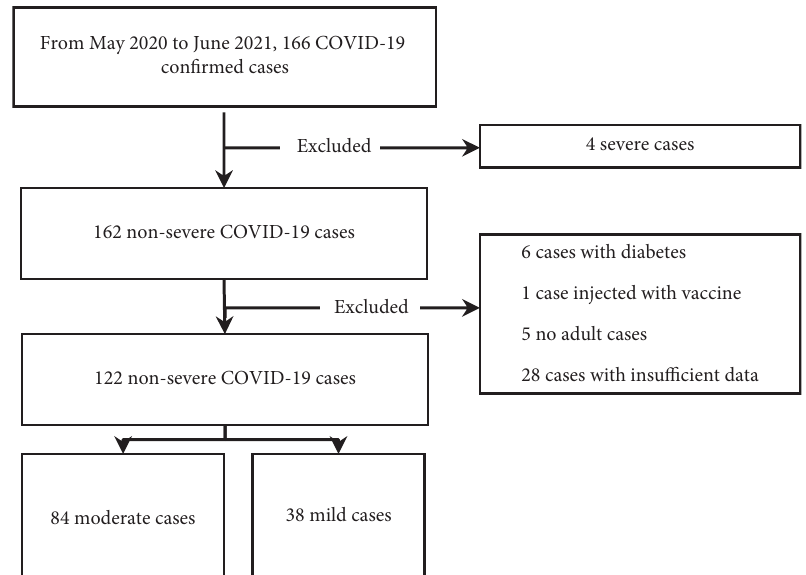
Figure 1: Flowchart of screening nonsevere COVID-19 confrmed cases. Table 1: Patient demographics and baseline characteristics of nonsevere COVID-19.